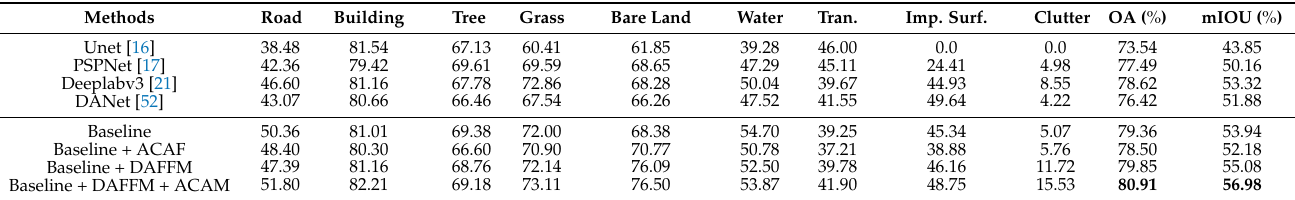
Table 4. Comparison with state-of-the-art methods on the GaoFen-2 dataset [36].